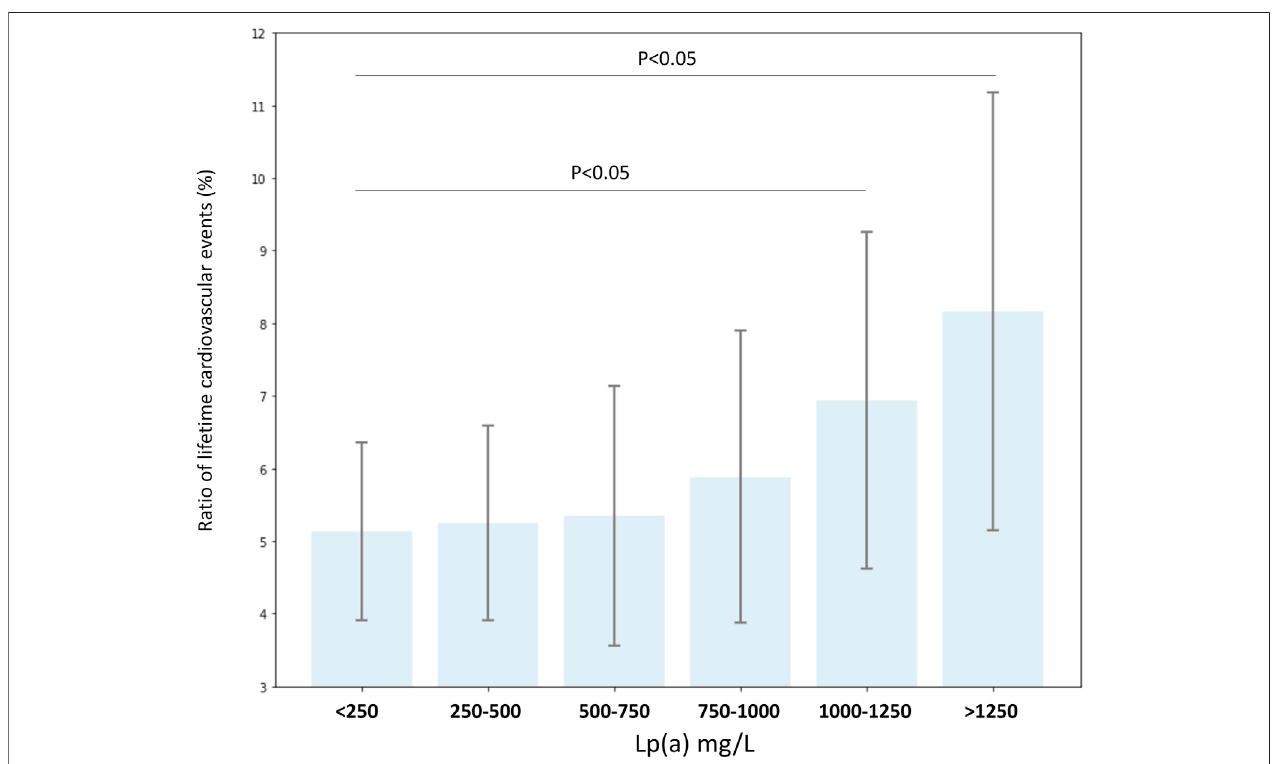
FIGURE3 | Ratio oflifetimecardiovascularevents (%) according toserum lipoprotein(a) level groups in all FHand non-FH patientswith known lipoprotein(a)